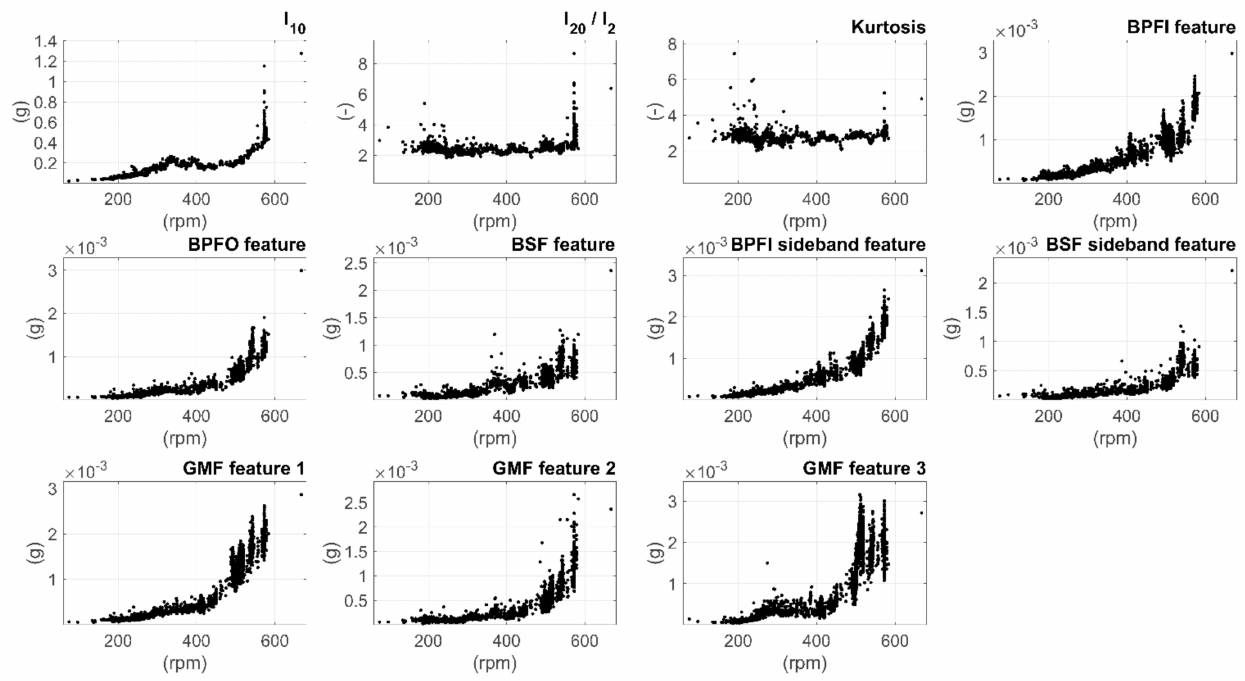
Figure 7. Scatter plots between feature values and rotational speed using the largest training set with 3000